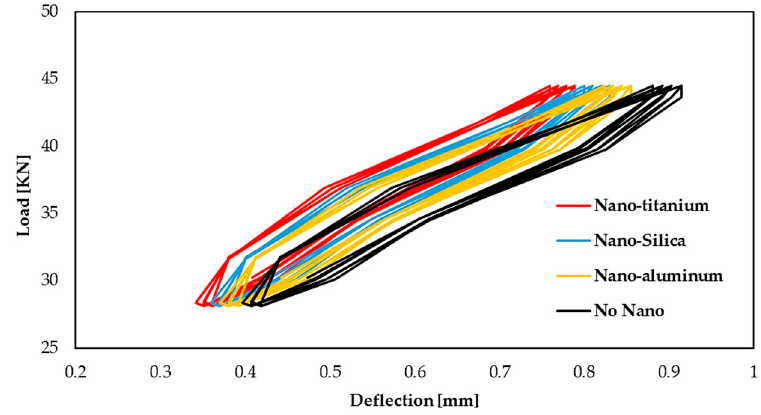
Figure 7. Load-deflection curves for the tested beams. Figure 7. Load ‐ deflection curves for the tested beams. Figure 7. Load ‐ deflection curves for the tested beams.